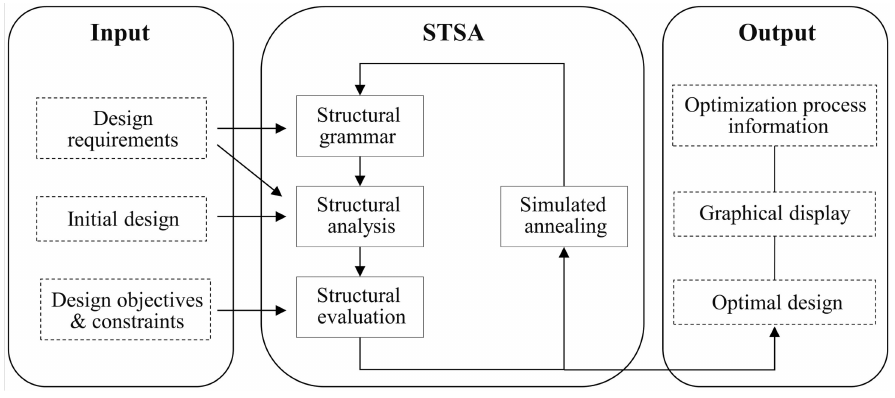
Figure 9. Flow chartof